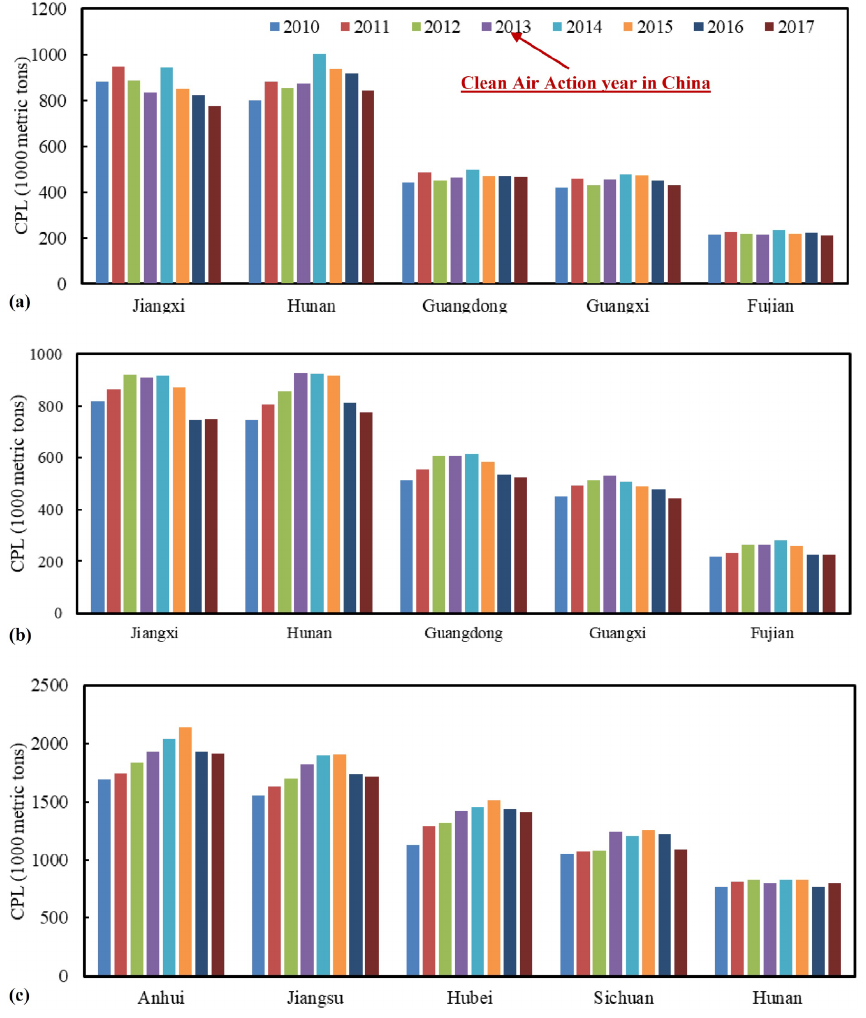
Figure 6. The production losses for rice, including (a) double early rice, (b) double late rice, and (c) single rice in all the China provinces. Unit is thousands metric